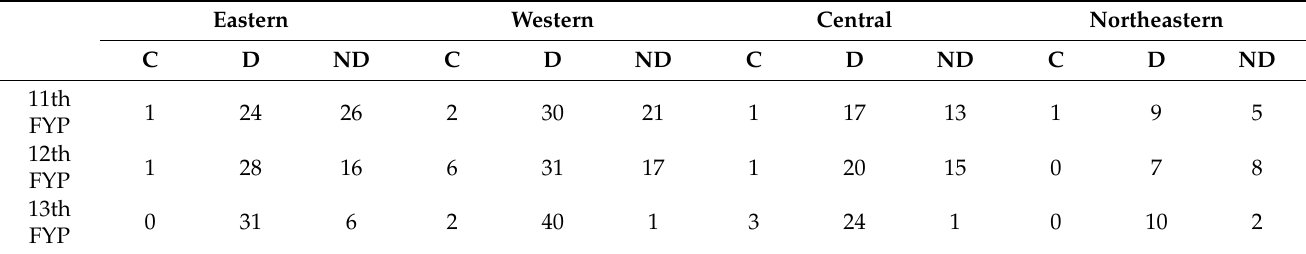
Table 6. Spatial differences of the number of provinces in three decoupling